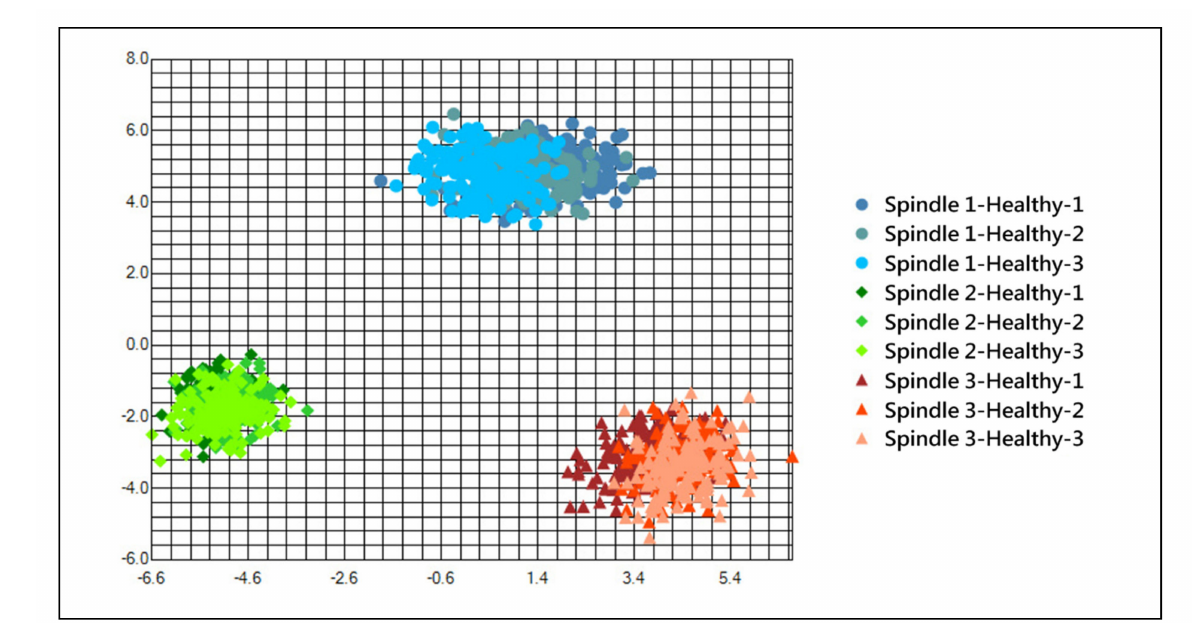
Figure 8. Spindle healthy state distribution map.